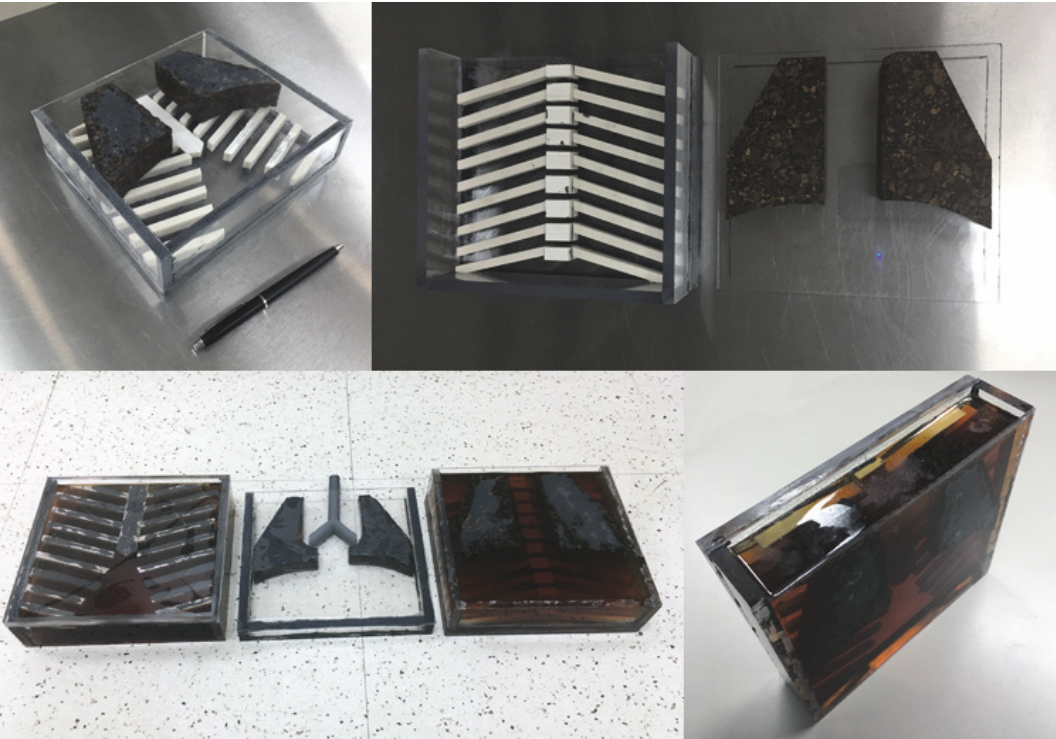
Figure 1: Components of the phantom assembly. Clockwise from top left: the anterior frame with LE and BE inserts. The posterior frame with the BE insert and the LE insert not attached yet. The anterior slab view from the side with the SE poured in. All 3 slabs side by side for comparison with the SE poured in A and P